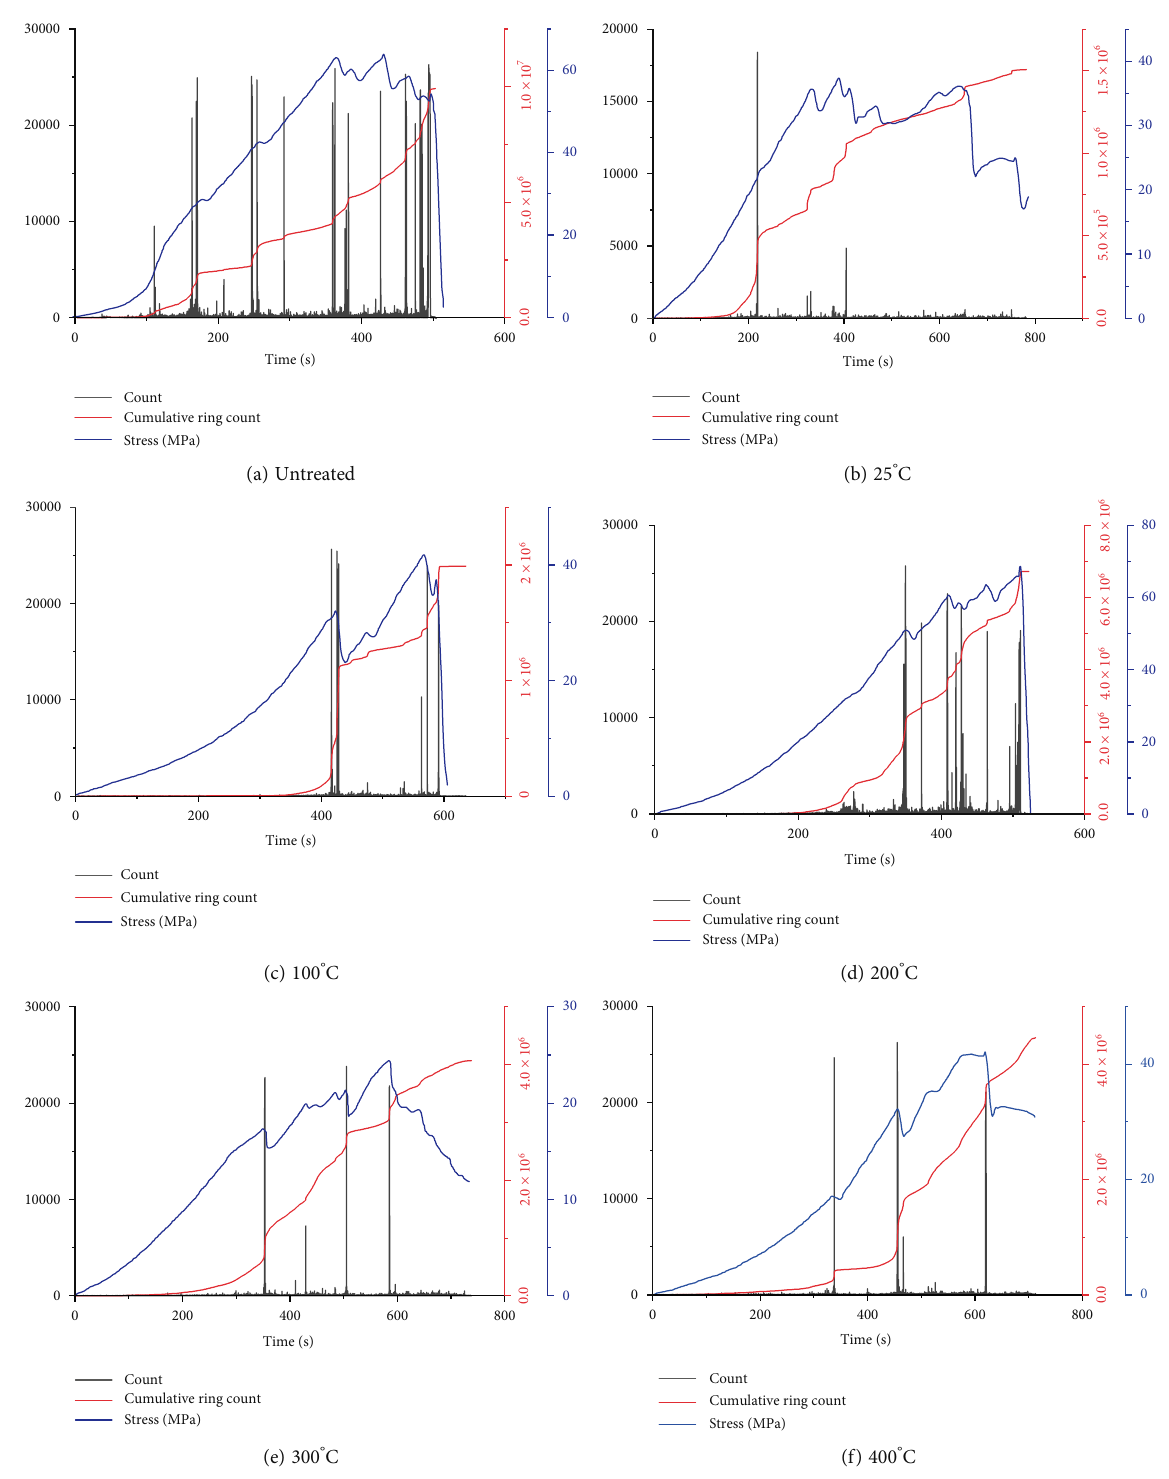
Figure 10: Variation of stress, ring count and cumulative ring count of granite with time under di ff erent initial